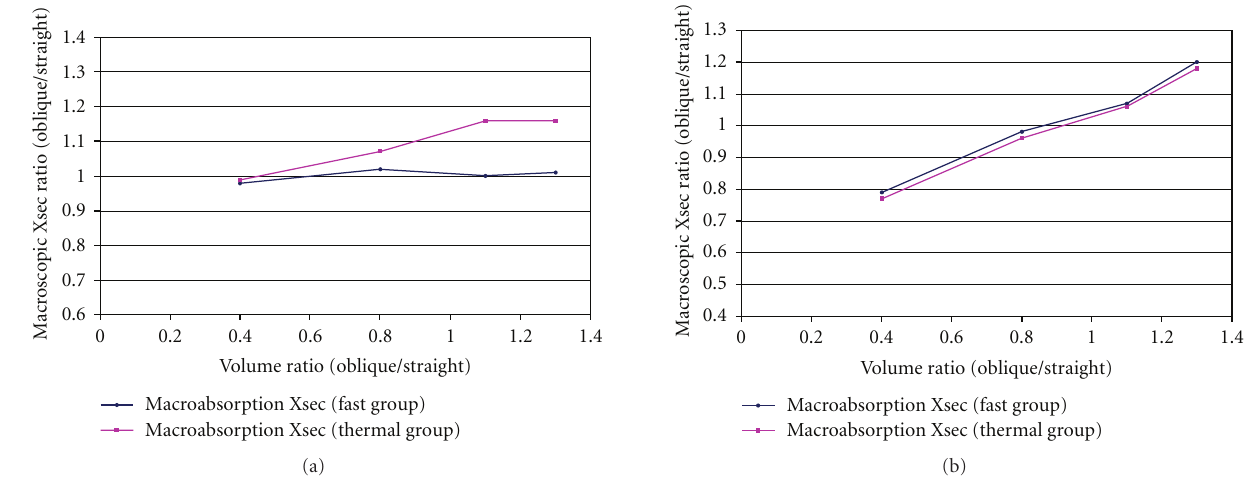
Figure 11: 3D e ff ects on absorption macroscopic cross sections (gray CR and black